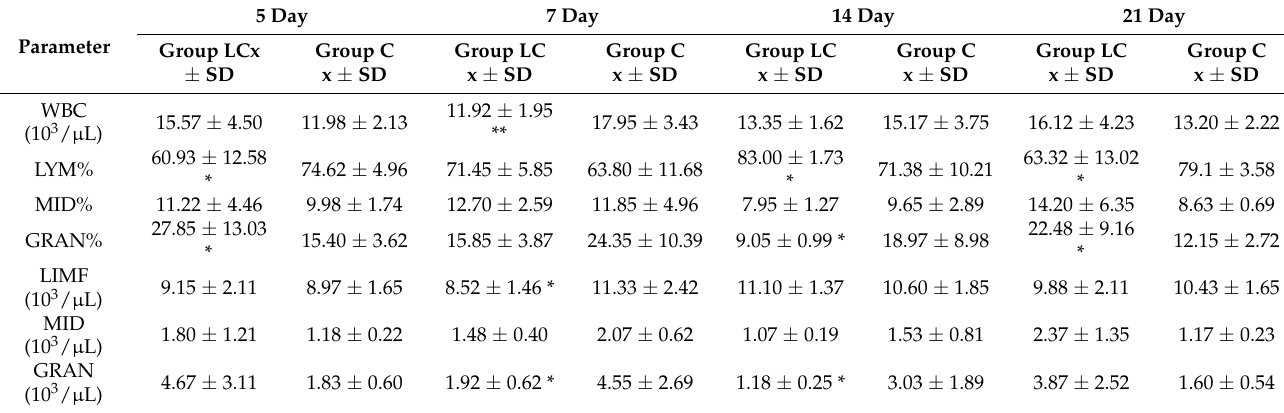
Table 9. Blood parameters in uninfected mice (control) (Group C) and uninfected mice receiving LC extract (Group LC). Mean values ( n = 6) and standard deviations are presented. * p < 0.05, ** p <